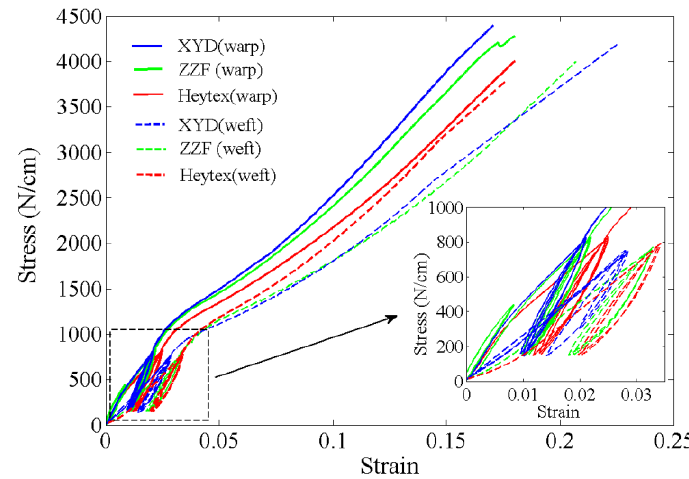
Figure 7. The stress-strain curves of membrane materials. Table 2. The brief introduction of membrane material.